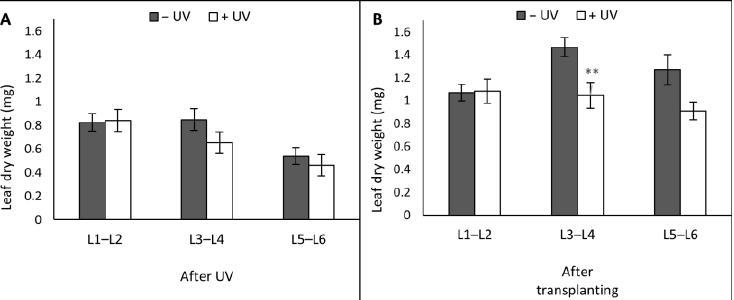
Figure 7. The parameter measured was the leaf dry weight (LDW, mg) across leaf L1 – L2, L3 – L4, and L5 – L6 after the UV ( A ) or after transplanting ( B ) . Before the UV exposure stage, the mean of the LDW for L1 – L2 was 0.876 mg, for L3 – L4 was 0.708 mg and for L5 – L6 was 0.170 mg. Asterisks indicate a significant difference between the UV treatments with p ≤ 0.001 (**).